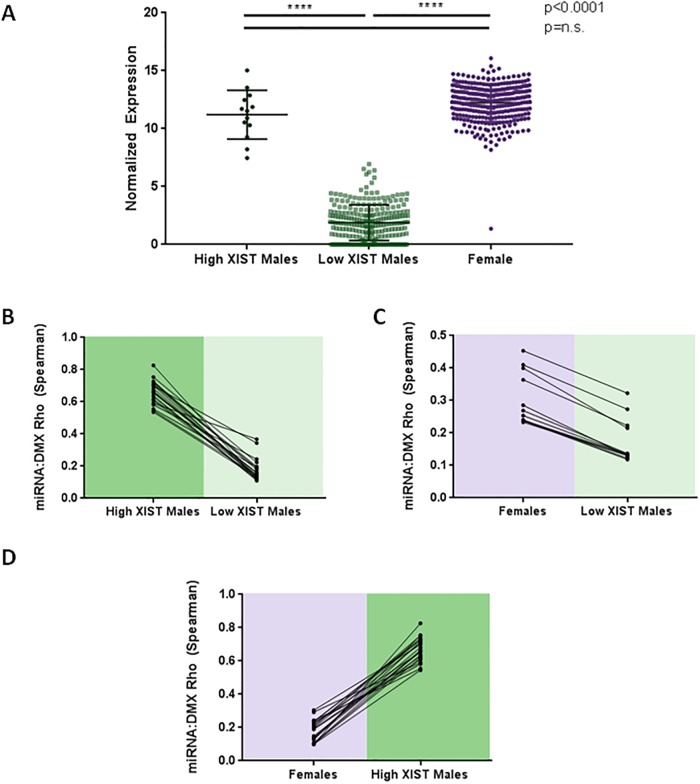
Males with High-XIST display female-like patterns.A) A subset of males have XIST expression equivalent to female expression levels (High-XIST males). B) When compared to Low-XIST males, High-XIST males show significantly stronger relationships between the candidate miRNA and DMX gene. C) Similarly, females display significantly stronger relationships between the candidate miRNA and corresponding DMX gene than Low-XIST males (change in Spearman’s coefficient of 0.1 or greater shown). D) When miRNA-DMX releationships are compared in High-XIST systems, males had significantly stronger correlation coefficients than females with equivalent levels of XIST.